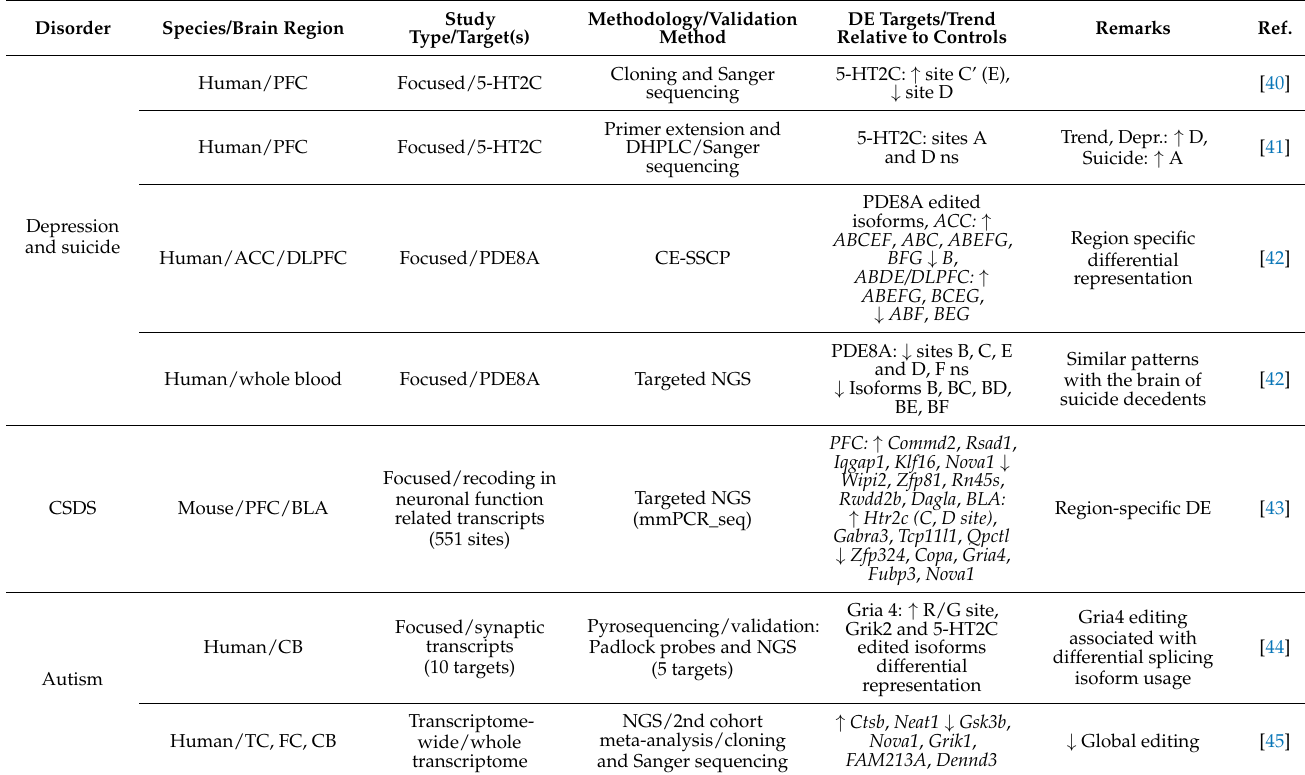
Table 2. Studies on RNA editing alterations in neurodegenerative disorders utilizing either